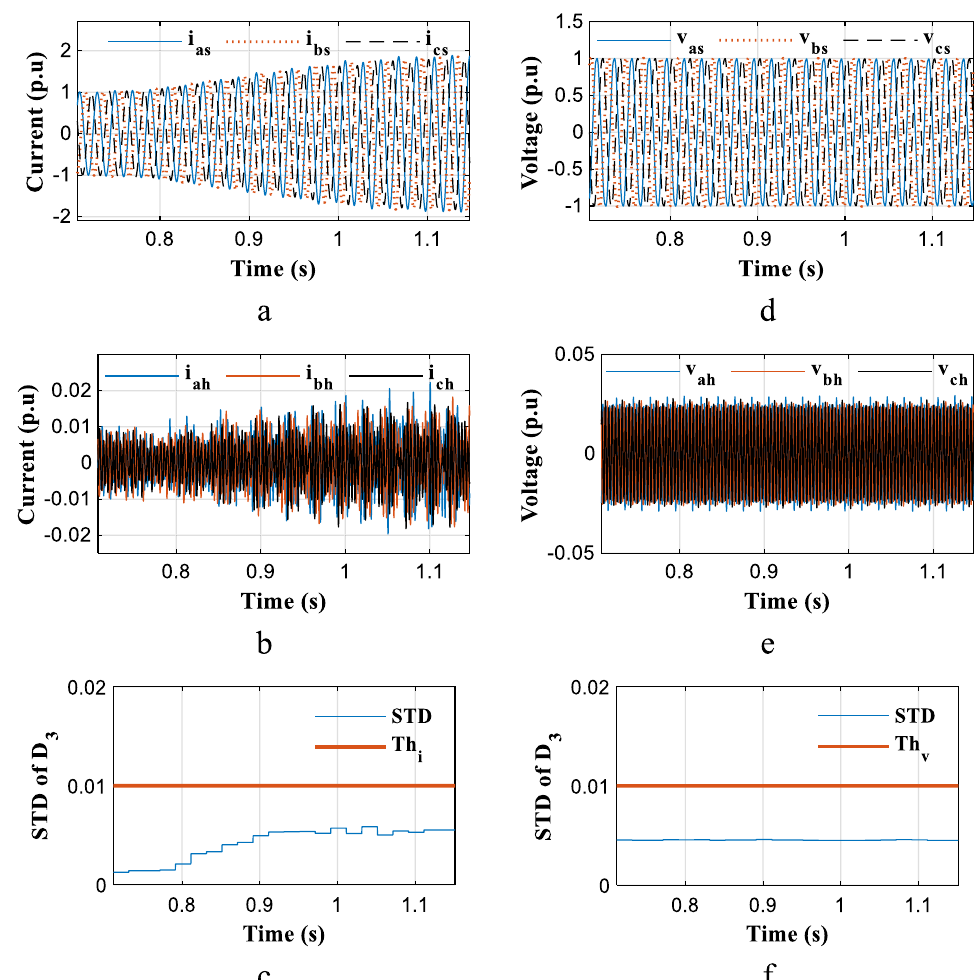
Fig. 20 Performance evaluation of proposed criteria using practical results for a mechanical load change 80%, a Three-phase stator current signals, b High-frequency components of three-phase stator current signals, c The current criterion, d Three-phase stator voltage signals, e High-frequency components of three-phase stator voltage signals, f The voltage criterion